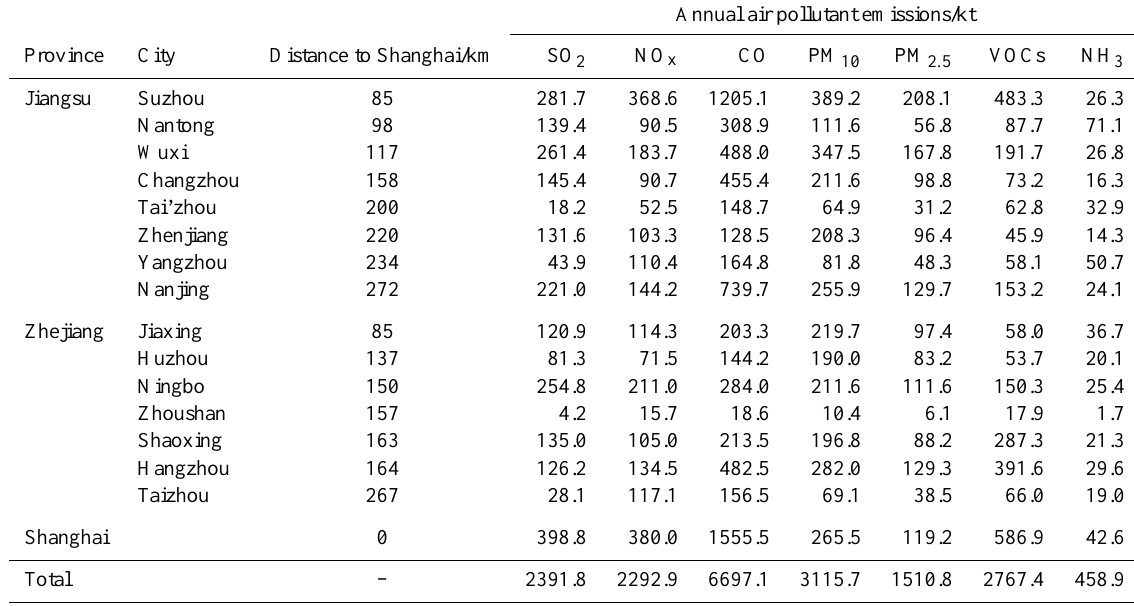
Annual air pollutant